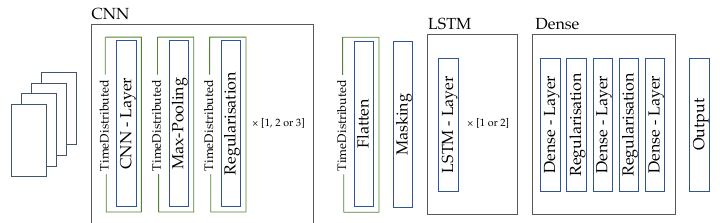
Figure 5. Network architecture of the